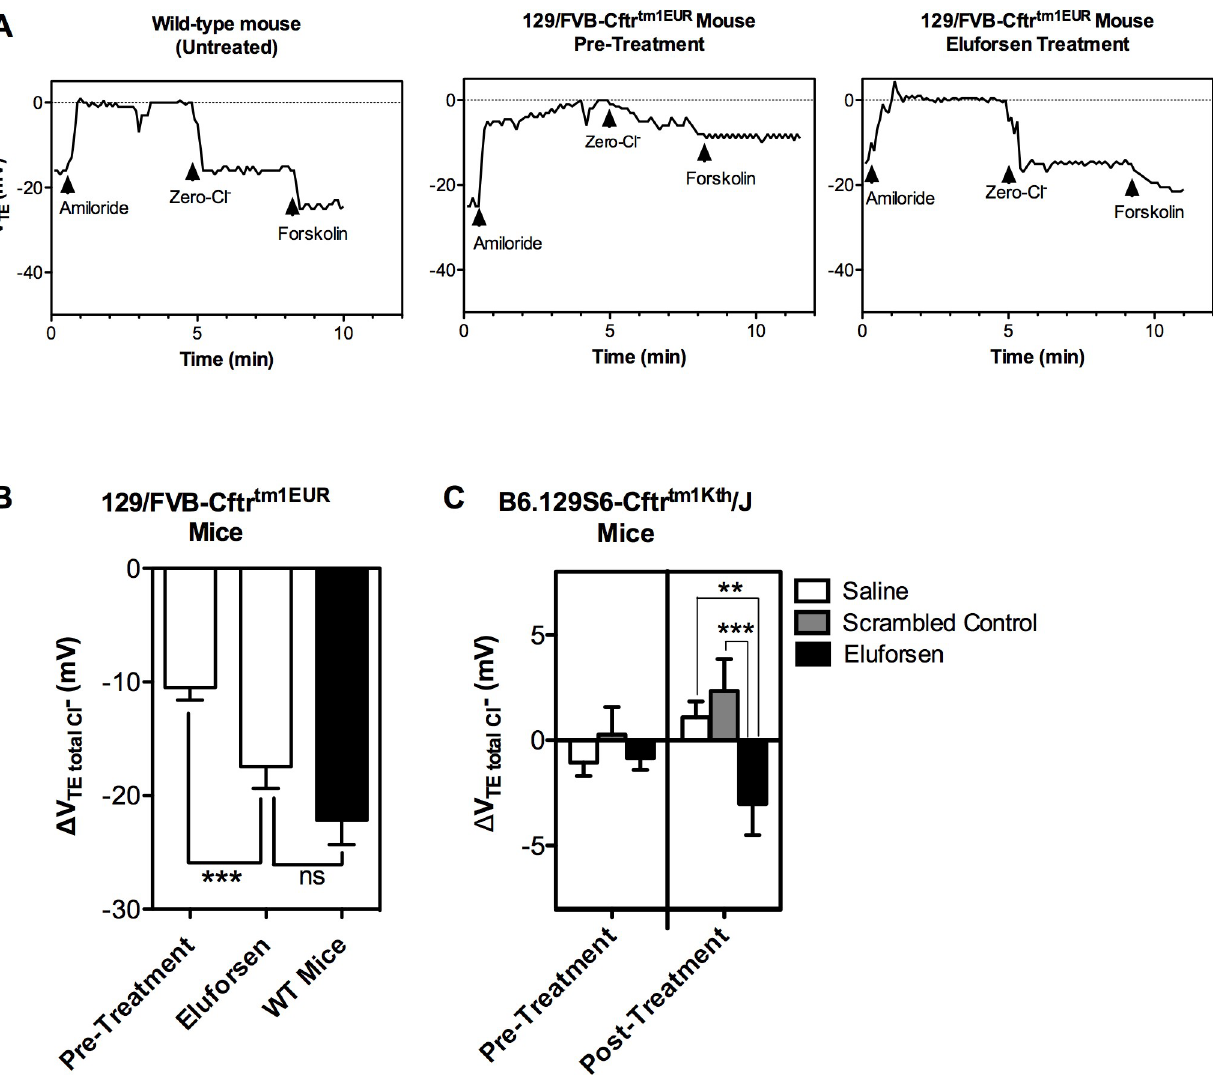
Fig 5. Eluforsen restores NPD in two different strains of F508del-CFTR mice. (A) Representative NPD traces in WT littermates, untreated 129/FVB Cftr tm1EUR mice, and eluforsen-treated 129/FVB Cftr tm1EUR mice. (B) Δ V TE total-Cl - obtained from NPD recordings in 129/FVB Cftr tm1EUR mice at pre- treatment and after six intranasal doses (EOD) of 40 μ g eluforsen (open bars; n = 18), and in untreated WT littermates (black bars; n = 6). Eluforsen significantly increases CFTR-mediated chloride permeability compared with pre-treatment levels, and to approximately 80% of WT levels. Bars show mean ± SEM. Δ V TE total-Cl - values in mice before and after eluforsen treatment were compared by paired t-test ( ��� p = 0.0001); the differences in Δ V TE total- Cl - values between eluforsen-treated and WT littermates were compared by unpaired t-test (ns: non-significant). (C) In B6.129S6-Cftr Δ V TE total-Cl � measurements at baseline were similar between treatment groups, but less negative compared with 129/FVB Cftr tm1EUR mice. At 24 hours post-treatment, eluforsen-treated mice (n = 10) had significantly improved Δ V TE total-Cl � (more negative) compared with both saline (n = 9) and the scrambled control (n = 10). Bars show mean ± SEM. The effect of eluforsen treatment on Δ V TE total-Cl � values was compared with the ANCOVA control groups using the pre-treatment NPD value ( �� p = 0.015, ��� p =